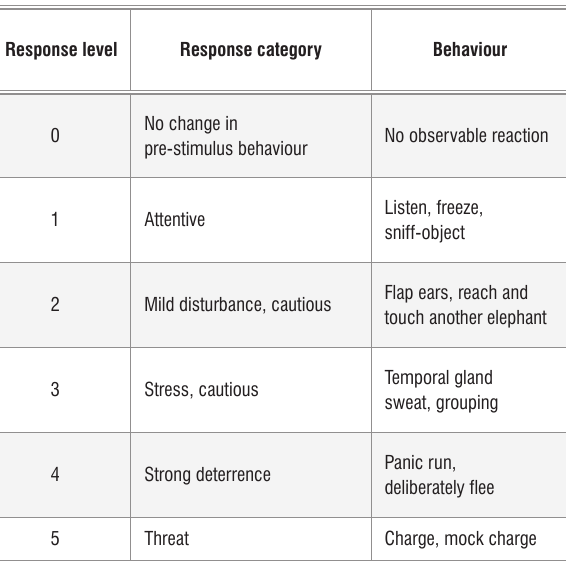
Classification of elephant behaviour into response levels as adapted from Estes